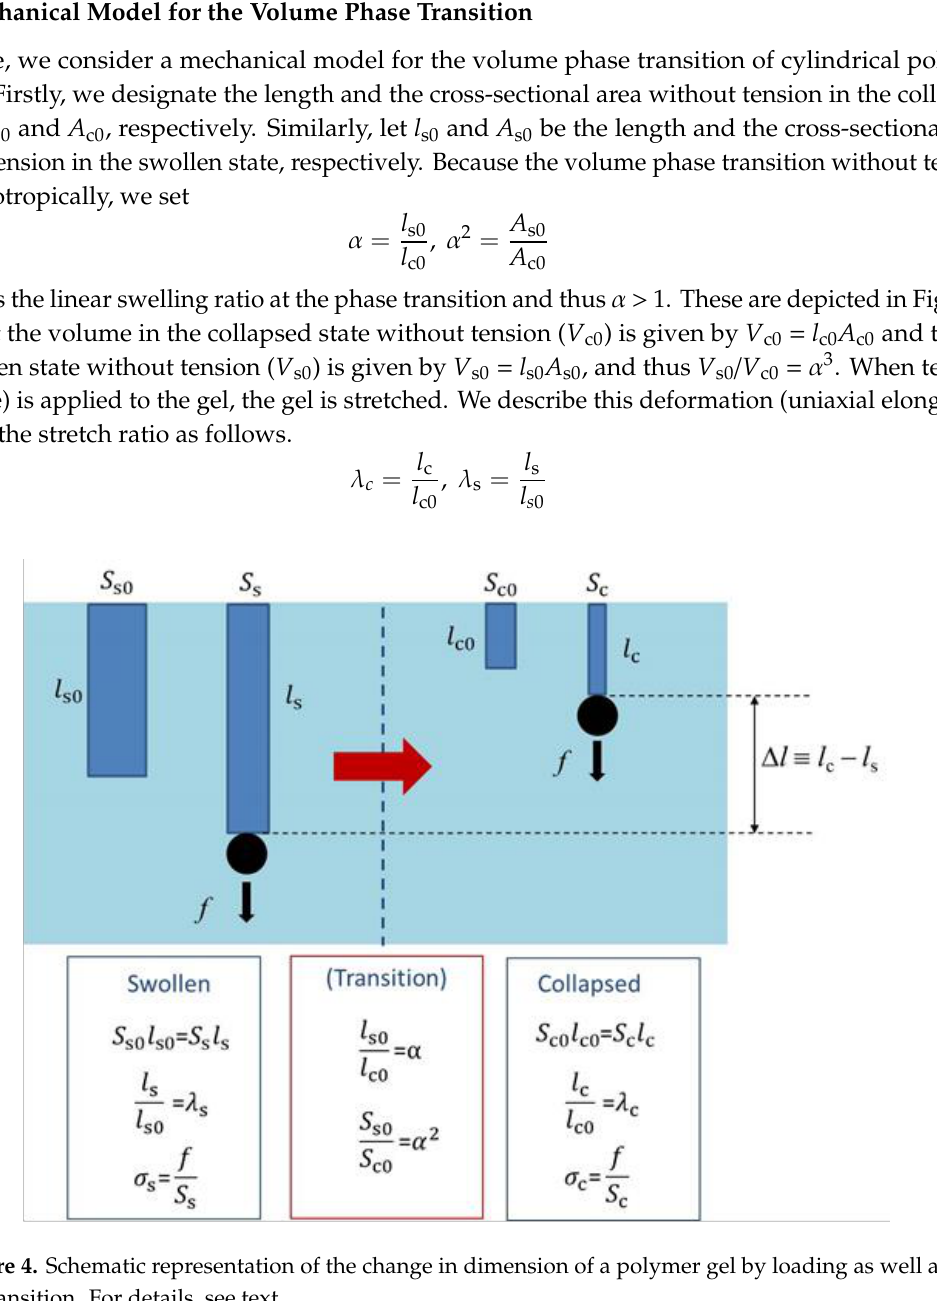
Figure 5. Expected force ( f ) dependence of the coefficient of performance ( c ) and the increment of the transition temperature (  T ).